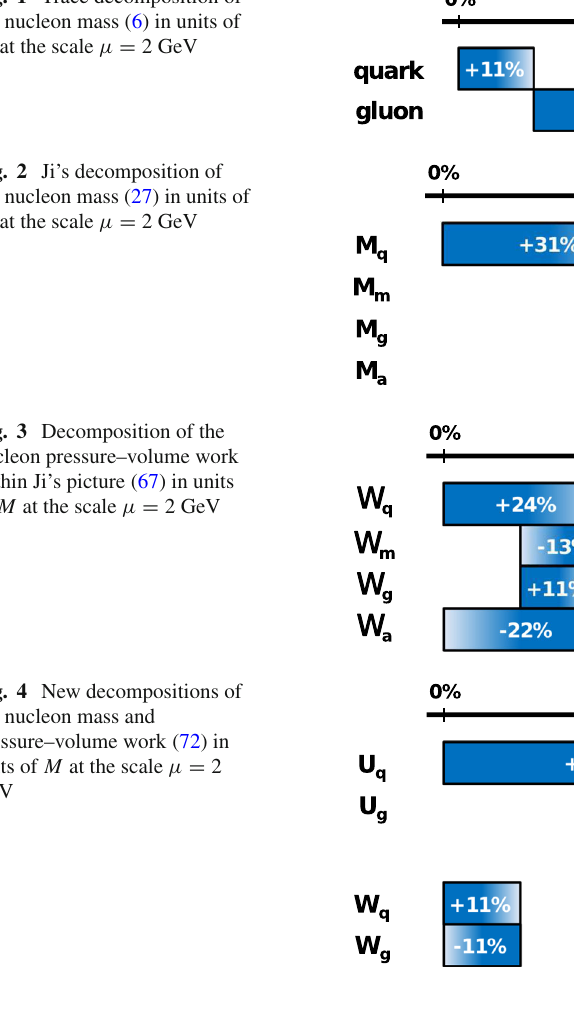
Fig. 1 Trace decomposition of the nucleon mass (6) in units of M at the scale μ = 2 GeV